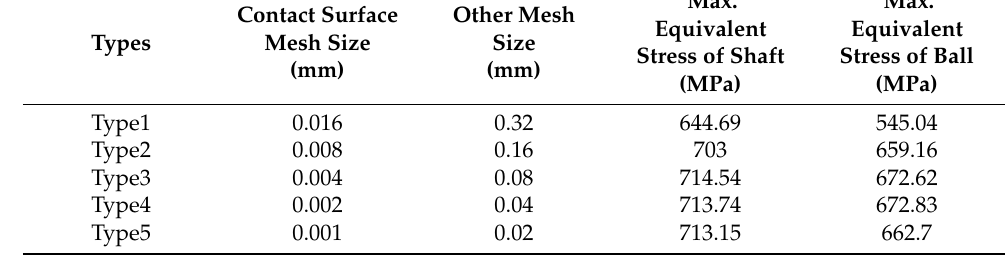
Figure 7. Boundary conditions of contact condition applied model.